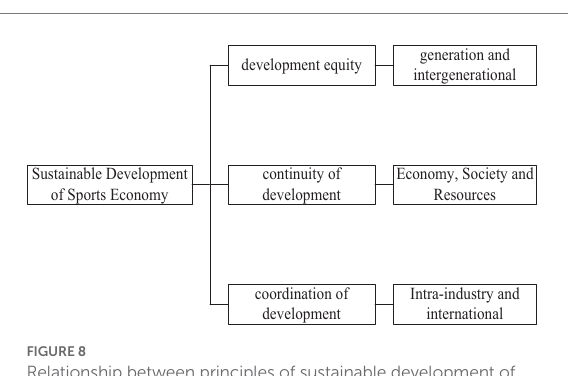
FIGURE 8 Relationship between principles of sustainable development of sports economy.